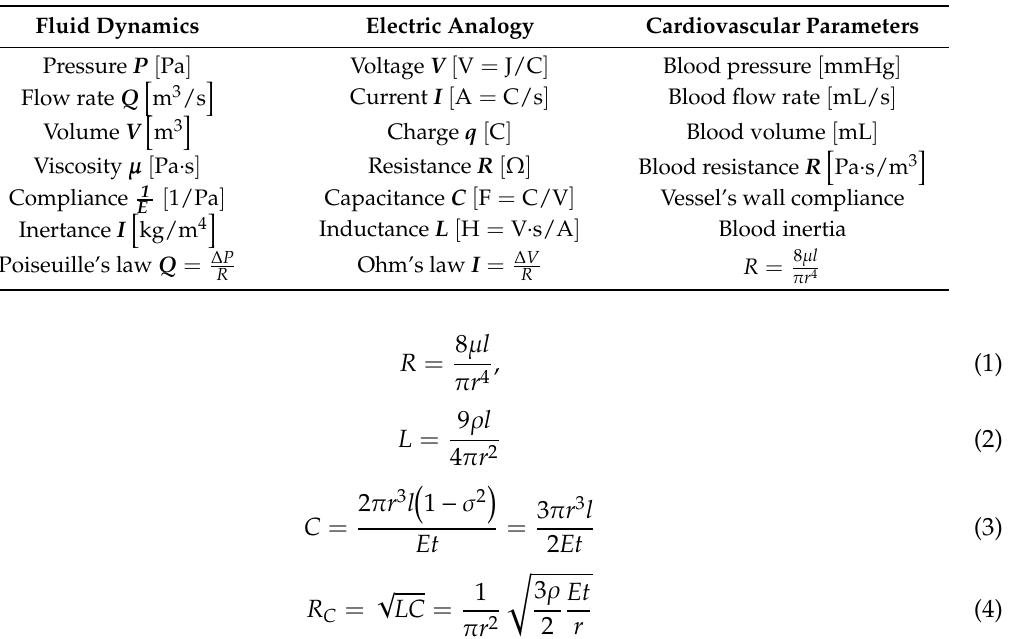
Table 1. Fluid mechanics, their electrical analogy and corresponding cardiovascular parameter.